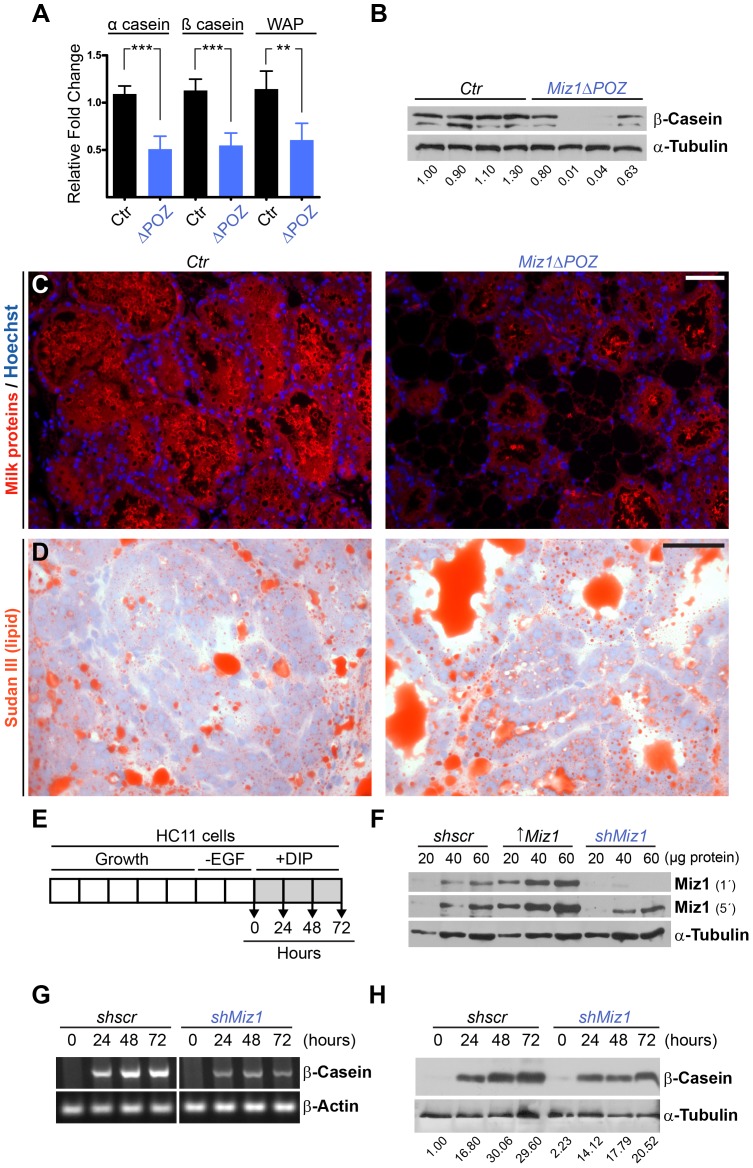
Differentiation of mammary gland epithelial cells in control (Ctr) and Miz1ΔPOZ tissue and in HC11 cells with reduced levels of Miz1.(A) Gene expression of the milk proteins α-casein, ß-casein and whey acidic protein (Wap), measured by quantitative RT-PCR, in control and Miz1ΔPOZ mammary gland tissue (ΔPOZ). (B) Immunoblot analysis for ß-casein from mice with the indicated phenotype. Each lane represents an individual animal. (C) Immunostaining with an antibody against milk proteins in the acini from control and Miz1ΔPOZ mammary glands. (D) Sudan III staining was performed on cryosections from lactating mammary glands of Ctr and MizΔPOZ mice (n = 4 per genotype). Data from A to D was obtained from lactation day 6 samples. (E) Time course of growth and differentiation as performed in the experiments with HC11 cells. EGF: epidermal growth factor; DIP: differentiation media containing dexamethasone, insulin and prolactin. Time points indicated correlate to the time points in (G) and (H). (F) HC11 cells were stably transfected with scrambled short hairpin (sh) RNA (shscr), a Miz1 shRNA and a vector expressing Miz1 as a positive control. The film was exposed 1 and 5 minutes, respectively. (G) PCR and (H) Western blots revealed a down-regulation of ß-casein when Miz1 concentration is decreased. Numbers indicated in (B) and (H) are fold changes of band intensities obtained by densitometry (see Materials and Methods). Scale Bar in C: 50 µm; D: 100 µm.